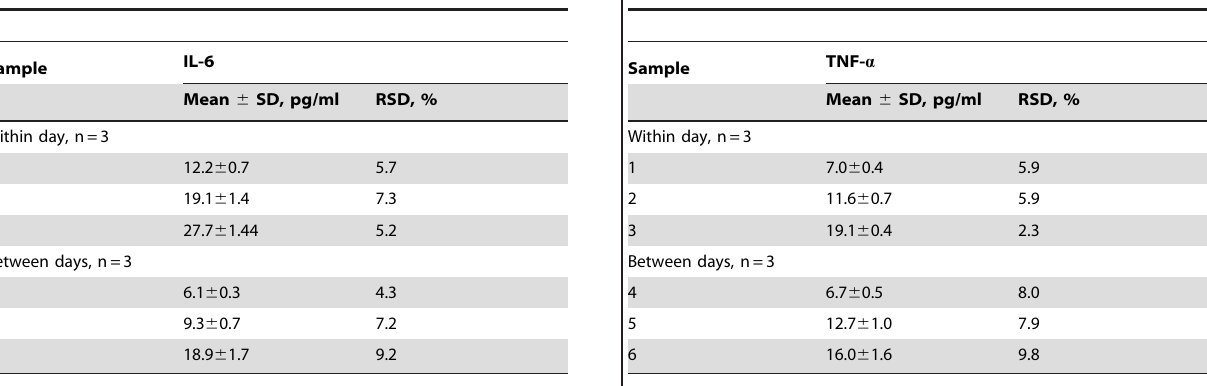
Table 5. Reproducibility of microchip method for the determination of IL-6 in plasma samples.